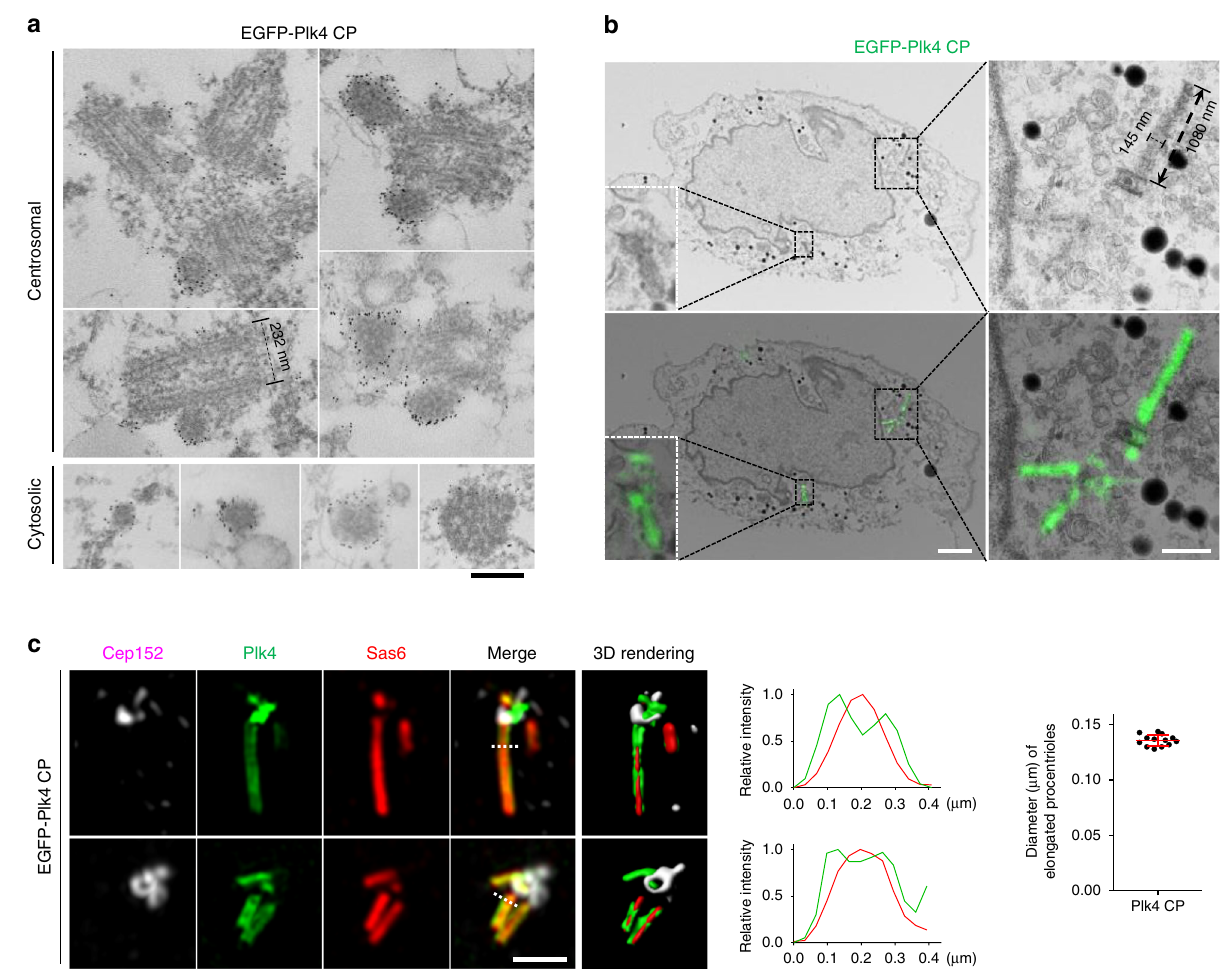
Fig. 3 A condensation-pro fi cient Plk4 CP mutant generates nanoscale, electron-dense bodies and localizes along an elongated procentriole. a Thin-section transmission electron microscopy (TEM) showing U2OS cells stably expressing EGFP-Plk4 CP stained with an anti-GFP and a 6-nm nanogold-conjugated secondary antibody. Both centrosomal and cytosolic Plk4 condensates decorated with nanogold signals are shown. Bar, 0.2 μ m. b Correlative light and electron microscopy (CLEM) analysis of U2OS cells stably expressing EGFP-Plk4 CP. Electron micrographs overlaid with GFP fl uorescent 3D-SIM images are shown at the bottom. Bar, 2 μ m. Dotted boxes, areas of enlargement. Bar, 0.5 μ m. The dimension of an elongated electron-dense body induced by Plk4 CP is shown. c Two 3D-SIM images showing tubular EGFP-Plk4 signals observed in U2OS cells. Plk4 and Sas6 signals were detected along the length of elongated procentrioles. The images were subjected to 3D surface rendering (see Supplemental Movie S1). Bar, 1 μ m. Dotted lines traversing the elongated procentrioles mark the region where the relative fl uorescence intensities for Plk4 and Sas6 were measured (middle). Bars in the graph (right), an average peak-to-peak distance across the tubular EGFP-Plk4 signals ( n = 13) with s.d. Source data are provided as a Source Data fi le for